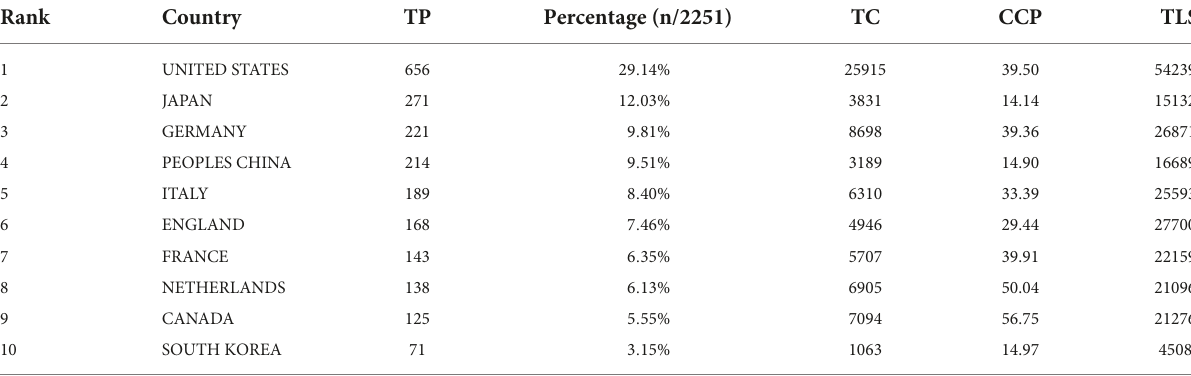
TABLE 1 The top 10 productive Country/Region of sick sinus syndrome.